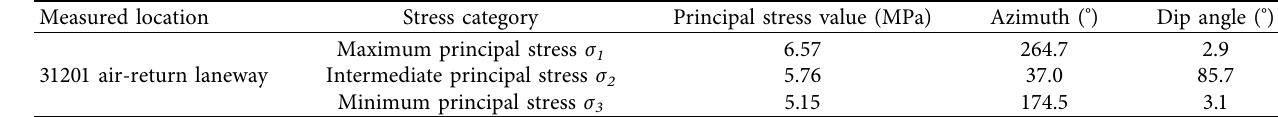
plastic deformation of the overburden strata can be shown in Figure 4. The distance and strength analysis results of the first roof weighting and periodic weighting are shown in Figure 5. The process of fracture development in the overlying rock layer is shown in Figure 6.